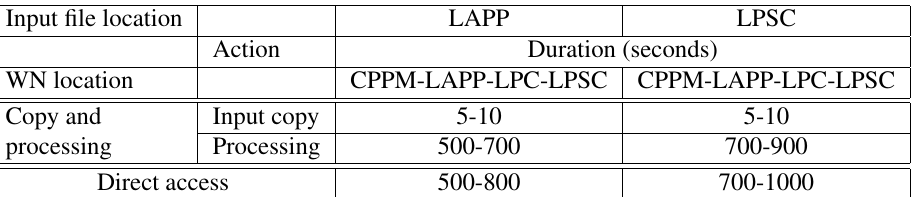
Table 1. Duration of simulation job components for di ff erent WN locations, and access mode for input files located at LAPP and LPSC.